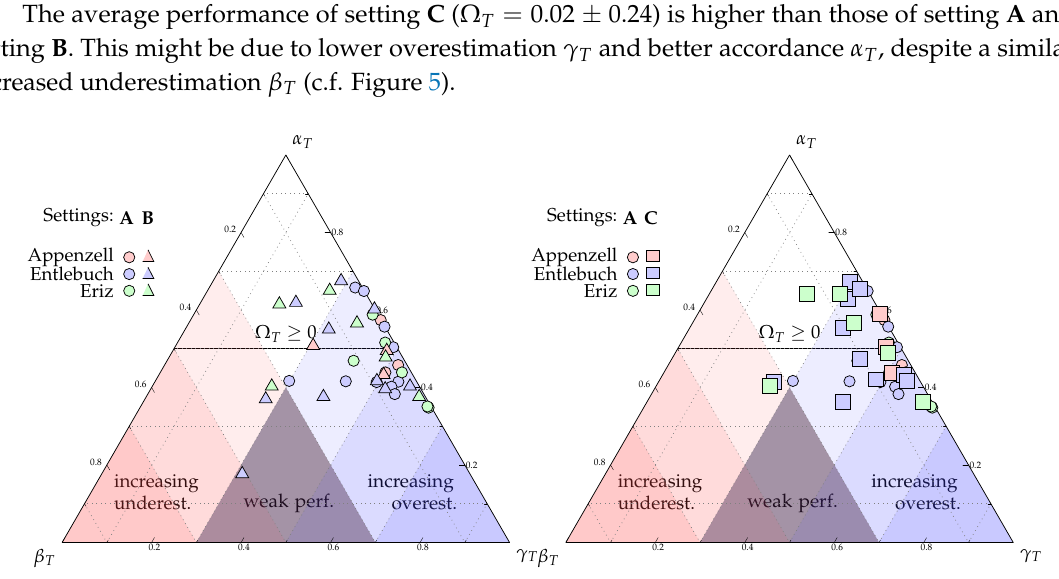
Figure 5. Graphical displays to compare the resulting Ω T values for the simulation settings A and B (left figure) and A and C (right figure). The right and left increasing colour ranges indicate increasing over- or underestimation of performance ( γ T , β T > 30%). Weak performance is defined by α T < 40% and γ T , β T >